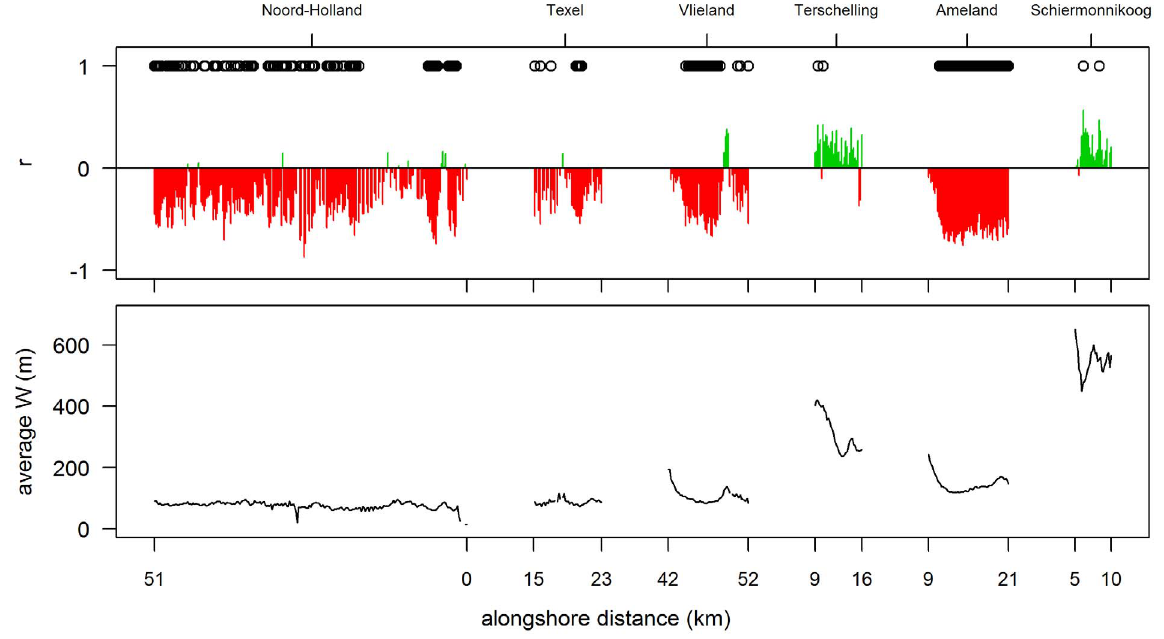
Figure 7. Temporal correlation of dune-volume changes ( D V) and storminess (S). Upper panel: correlation between dune-volume changes ( D V) and storminess (S). Correlation was calculated as the Pearson product-moment coefficient r. Correlations significant at p , 0.05 level are indicated with ‘o’. Lower panel: time-averaged beach width (W) for each profile. The numbers on the x-axis refer to the boundaries of each location.